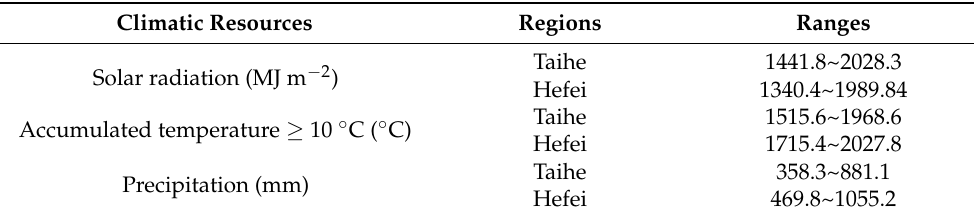
Table 7. Climatic resources of different